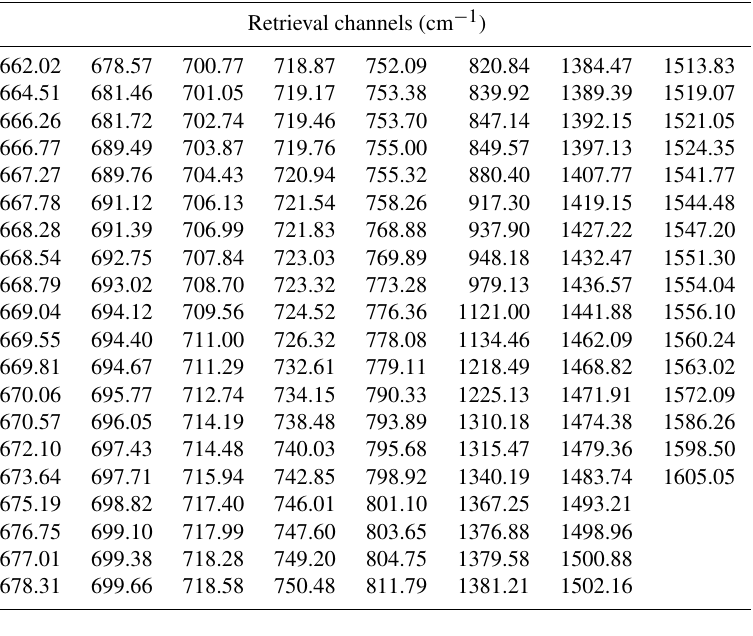
Table 2. AIRS retrieval channel frequencies used for this